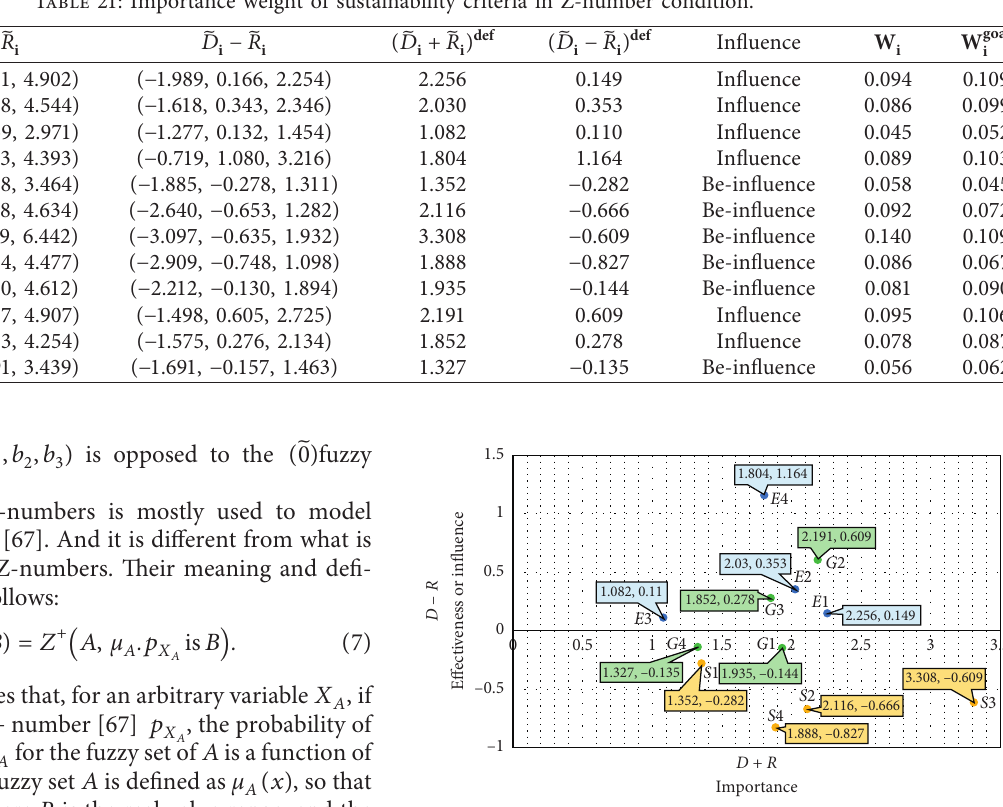
Figure 8: Effectiveness or influence and importance of sustain- ability